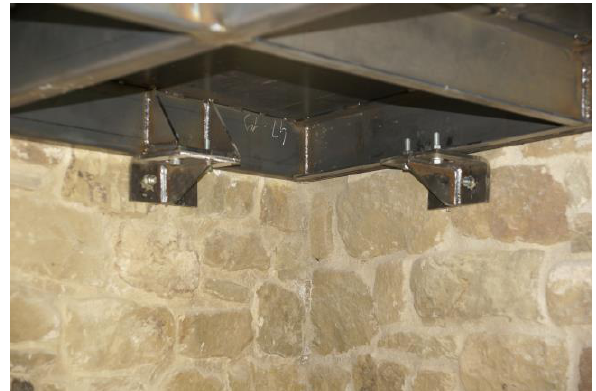
Figure 13. The ladder fixing systemof the COR-TEN